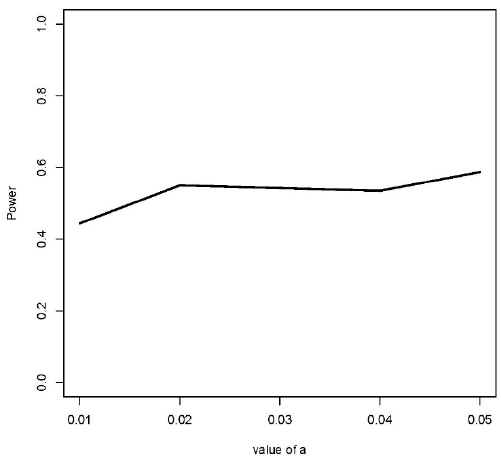
Figure 7. Estimated power for the alternative case #3.